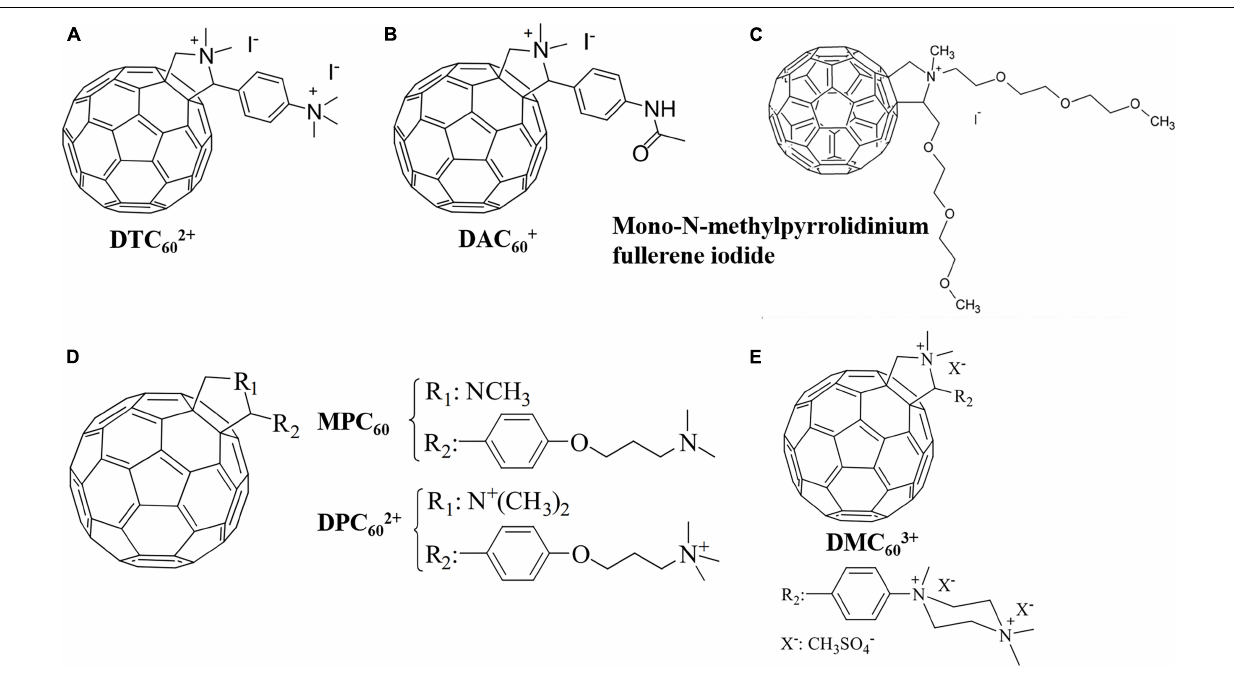
incubation with 0.5 µ M fullerene and irradiation for 30